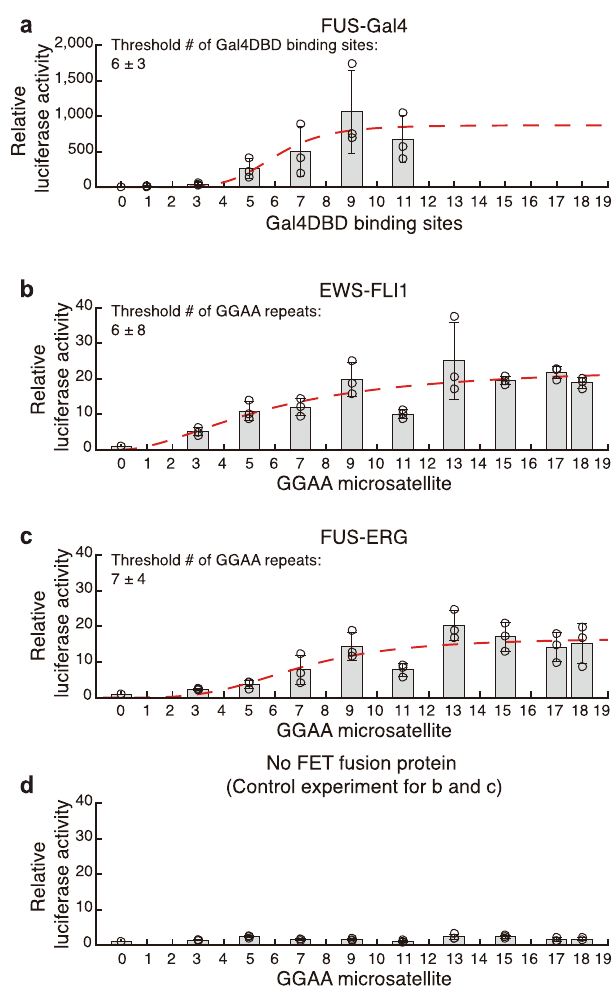
Fig. 5 The number of GGAA microsatellites is highly associated with the gene transcriptional regulation by FET fusion proteins. a - d Dual- luciferase assays were performed 24 h after transfection of 293 T cells with overexpression of either FUS-Gal4 a, EWS-FLI1 b, FUS-ERG c, or no fusion proteins d and a fi re fl y luciferase vector possessing the indicated number of consecutive binding motifs preceding a minimal promoter. Data are normalized to relative luciferase activity of empty vector condition. Independent dual-luciferase assays were repeated three times ( n = 3). Error bars, mean ± s.d. The red dashed line represents Hill function fi tting. Error bars of the fi tting parameters represent 95% con fi dence intervals obtained through Hill function fi